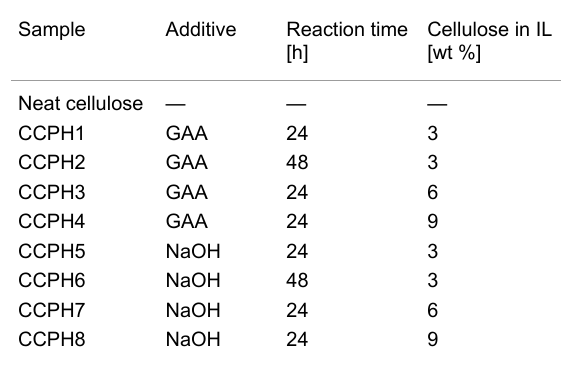
Table 3: Reaction conditions for preparation of cellulose calcium phos- phate hybrids (CCPH).